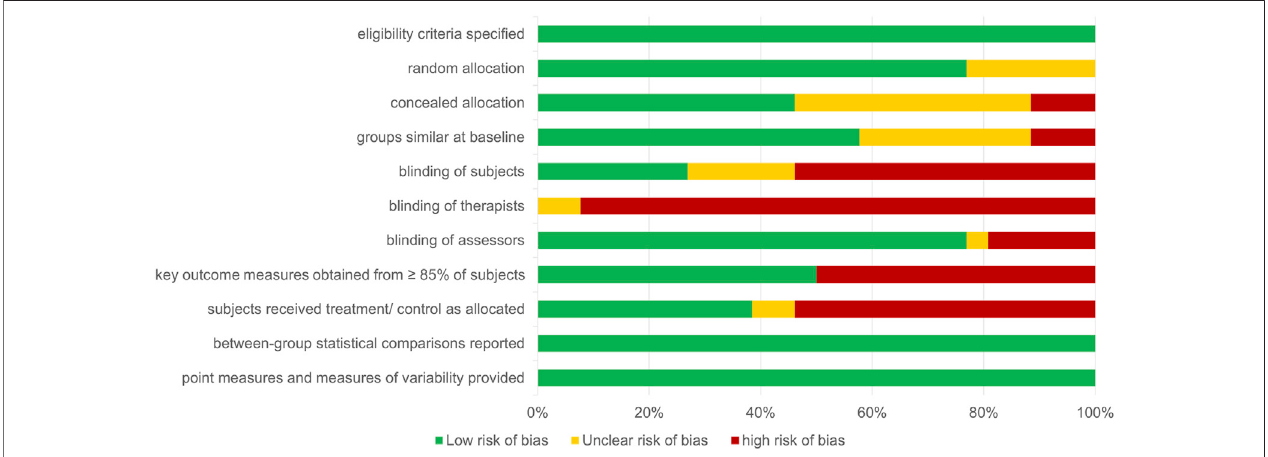
FIGURE3| Riskofbias assessment byPEDroitem, summary. Summaryofauthors ’ judgement onthe methodologicalquality ofincluded studiesassessed bythe 11-item PEDro scale. Results are given as percent of studies for each item. Overall, the detected risk of bias was high. Green indicates low risk of bias, yellow indicates unclear risk of bias, and red indicates high risk of